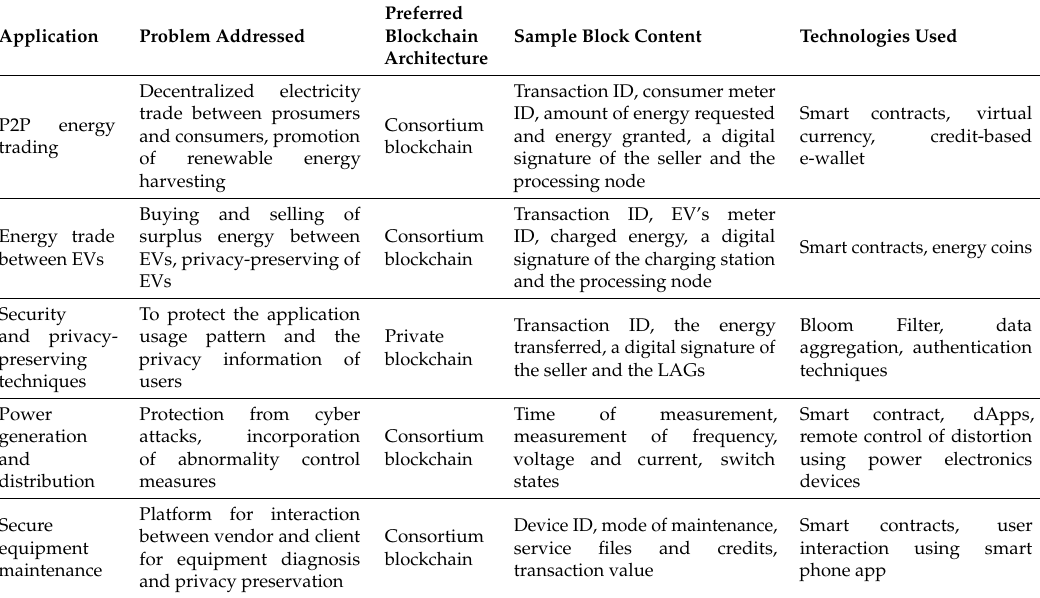
Table 6. Summary of blockchain applications in the smart